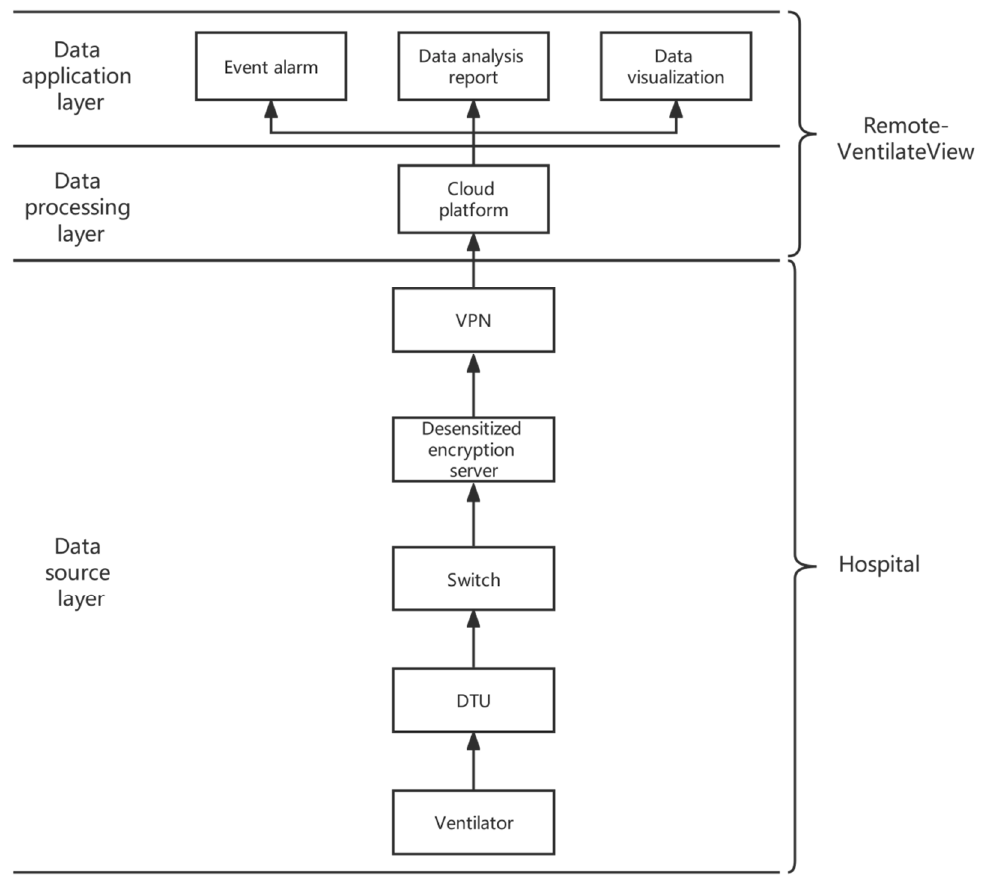
Figure 1. Remote-VentlateView platform architecture.